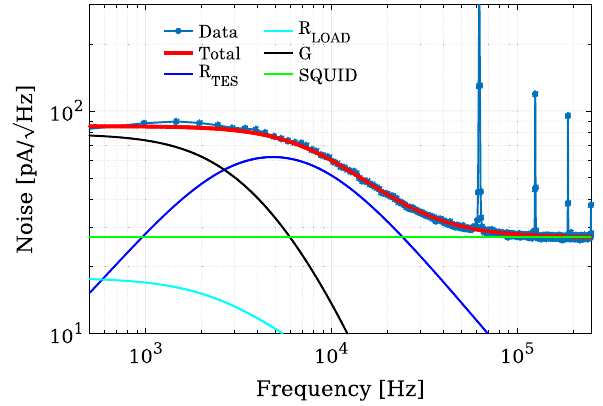
Fig. 7 Noise power spectral density measured with the detector a with all its individual contributions [14]. The SQUID noise ( green ) is limited by the HEMT amplifier noise; R TES ( dark blue ) and R LOAD ( light blue ) are contributions caused by the Johnson noise of the TES resistance and of the load resistance of the bias circuit, respectively; finally, the noisecontributionlabeledas“G”( black )isthethermalfluctuationnoise across the finite thermal conductance G . The peak at 62.5 kHz and its harmonics are due to an artifact of the demodulation algorithm. Nevertheless, these peaks do not contribute to the energy resolution thanks to the optimal filtering